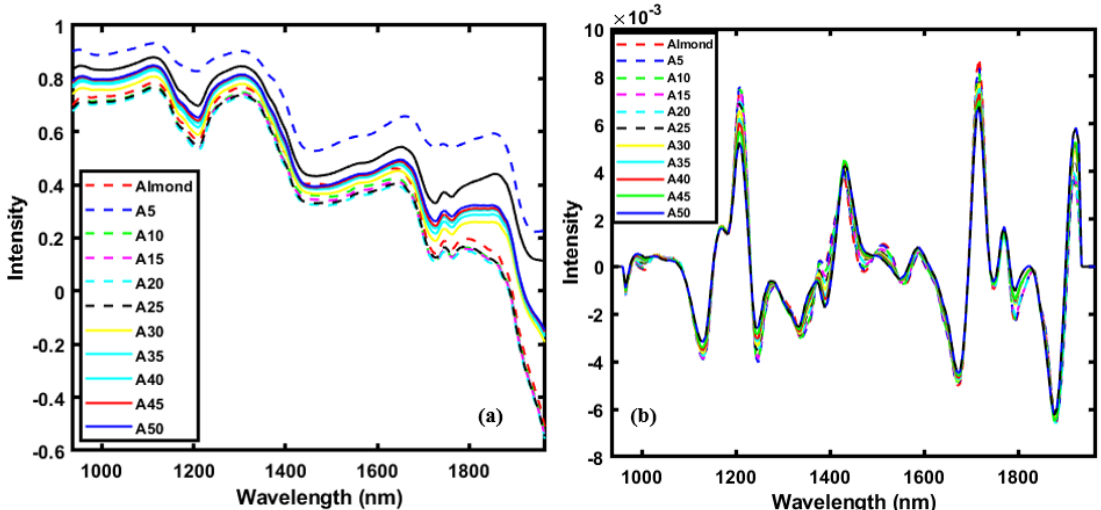
Figure 3. ( a ) Raw and ( b ) SG-2nd derivative pre-processed mean spectra of almond powder samples with di ff erent adulterant (apricot powder) concentrations.